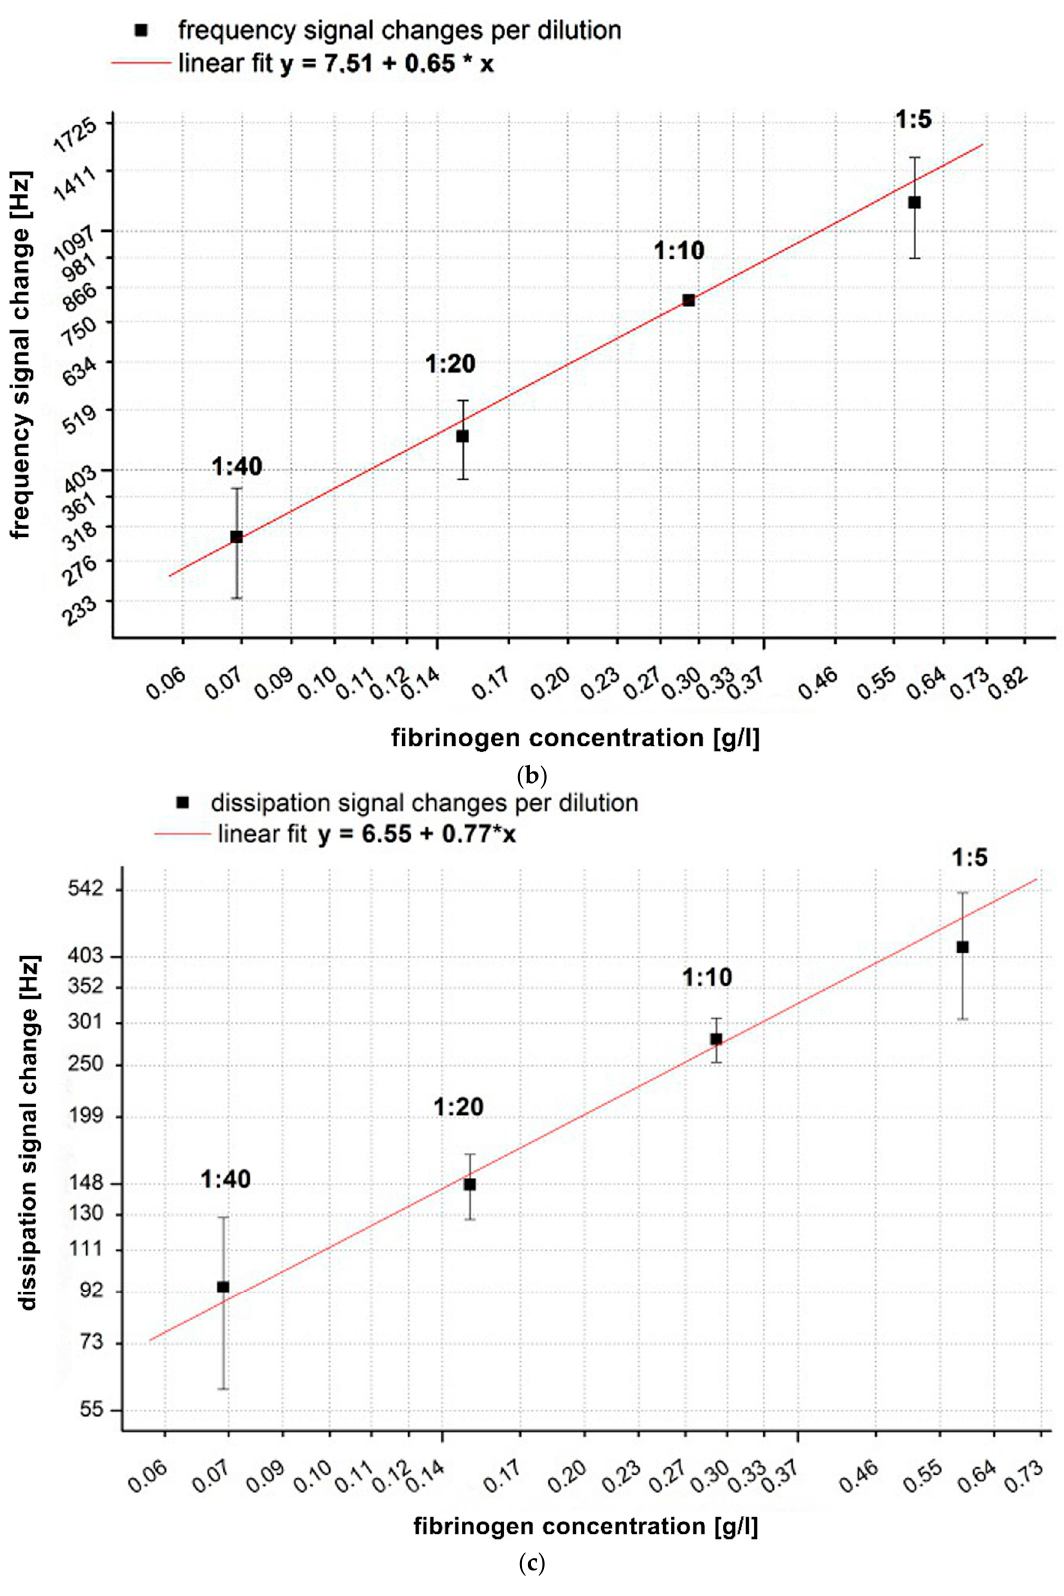
Figure 3. Cont . Figure 3.